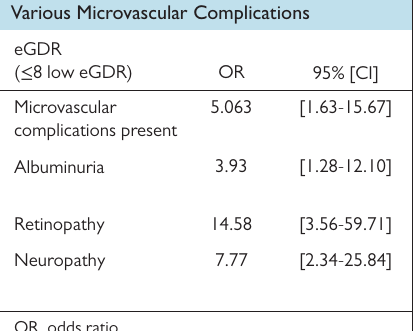
Table 6. Association of low eGDR with Various Microvascular